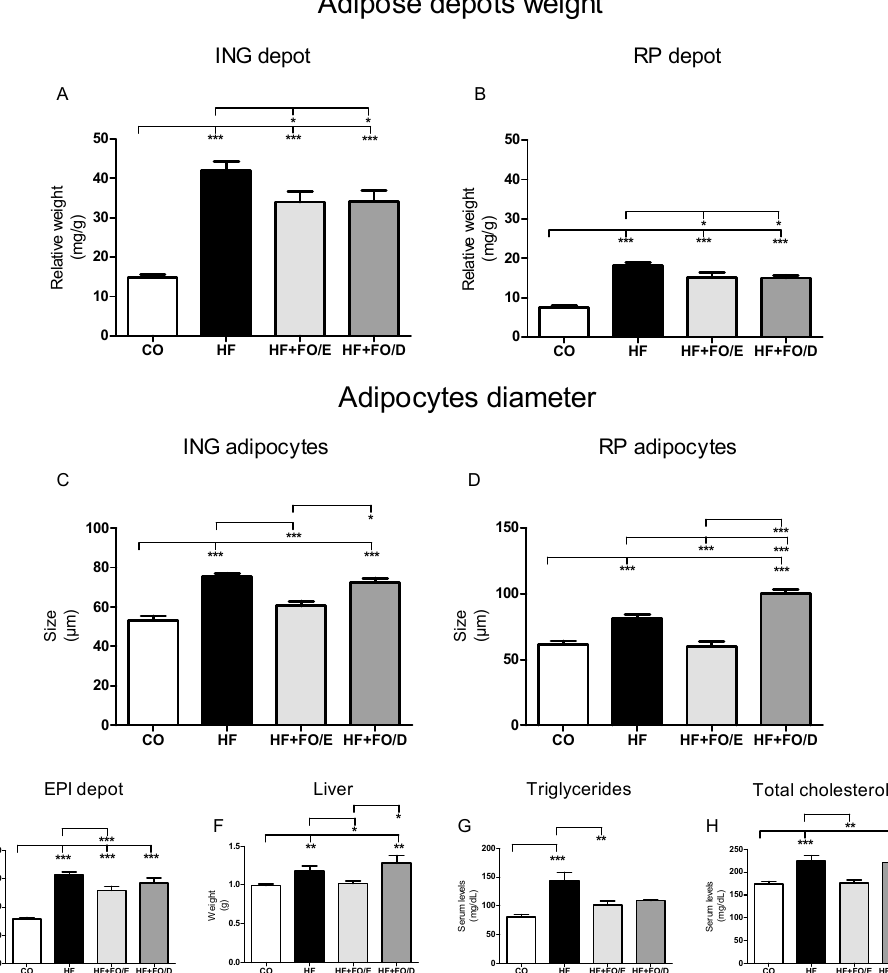
Figure 4. Adiposity and hypertrophy of adipocytes from ING and RP fat depots of mice fed with CO or HF diet and treated with FO. ( A ) relative weight (mg/g BW) of ING fat depot. ( B ) relative weight (mg/g BW) of RP fat depot. ( C ) diameter of ING adipocytes. ( D ) diameter of RP adipocytes. ( E ) relative weight (mg/g BW) of EPI fat depot. ( F ) absolute liver weight. ( G ) serum triglycerides. ( H ) serum total cholesterol. FO: fish oil; CO: control diet; HF: high fat diet; HF+FO/E, HF diet supplemented with FO containing high concentration of EPA; HF+FO/D, HF diet supplemented with FO containing high concentration of DHA; ING: inguinal; RP: retroperitoneal; EPI: epididymal; BW: body weight. Mean ± SEM. * p < 0.05, ** p < 0.01, *** p < 0.001.